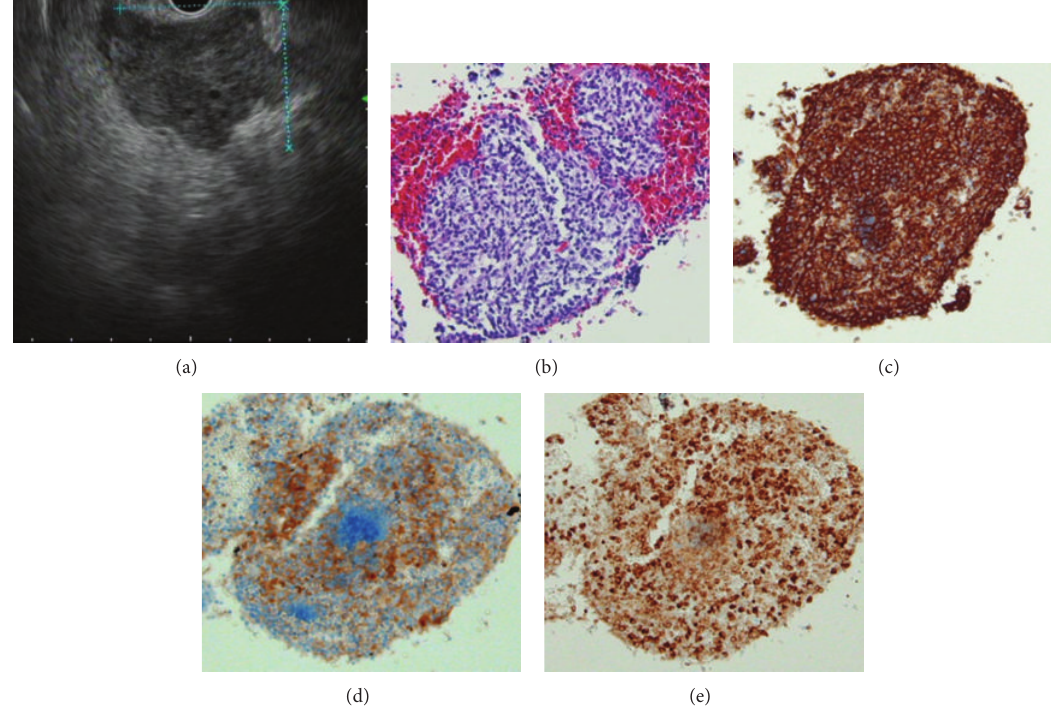
Figure 4: Endoscopic ultrasonography demonstrated an enlarged perigastric lymph node (a). Endoscopic ultrasonography-guided fine- needle aspiration biopsy revealed lymphoma cell infiltration in the lymph node (b) with positive staining for CD20 (c), CD10 (d), and BCL2 (e), indicating progression of the follicular